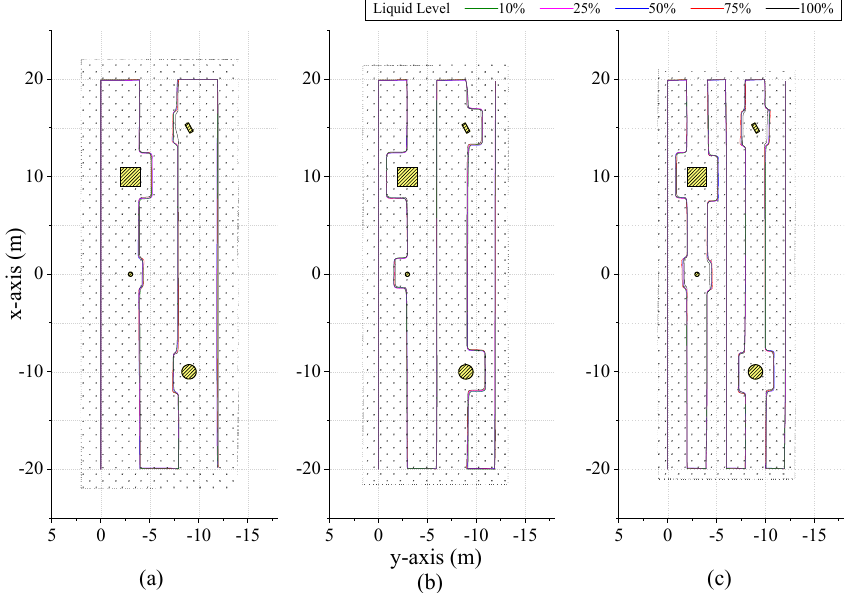
Figure 14. Different actions during different scenarios in farmland operation. ( a ) 4-m path gap, ( b ) 3-m path gap, ( c ) 2-m path gap.